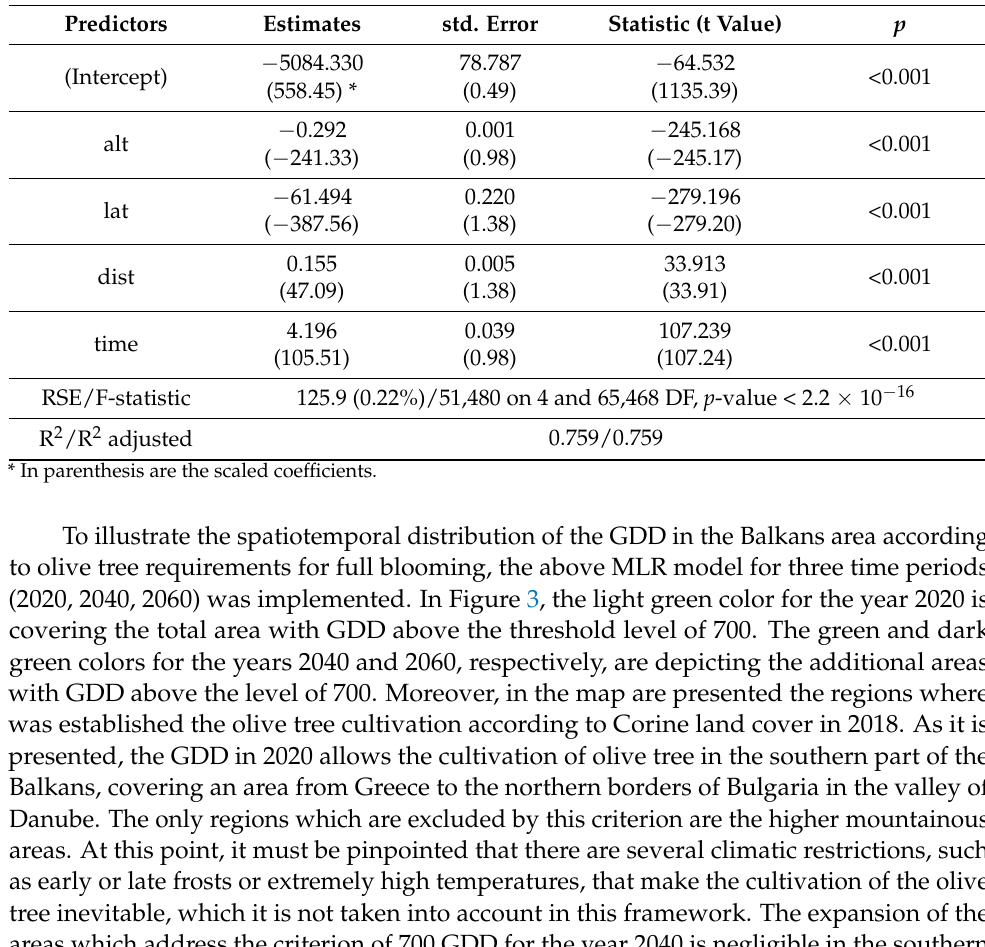
Table 3. Multiple linear regression model coefficients for the growing degree days (GDD) units of the olive tree cultivation. Olive Tree Cultivation GDD Multiple Linear Regression Coefficients GDD